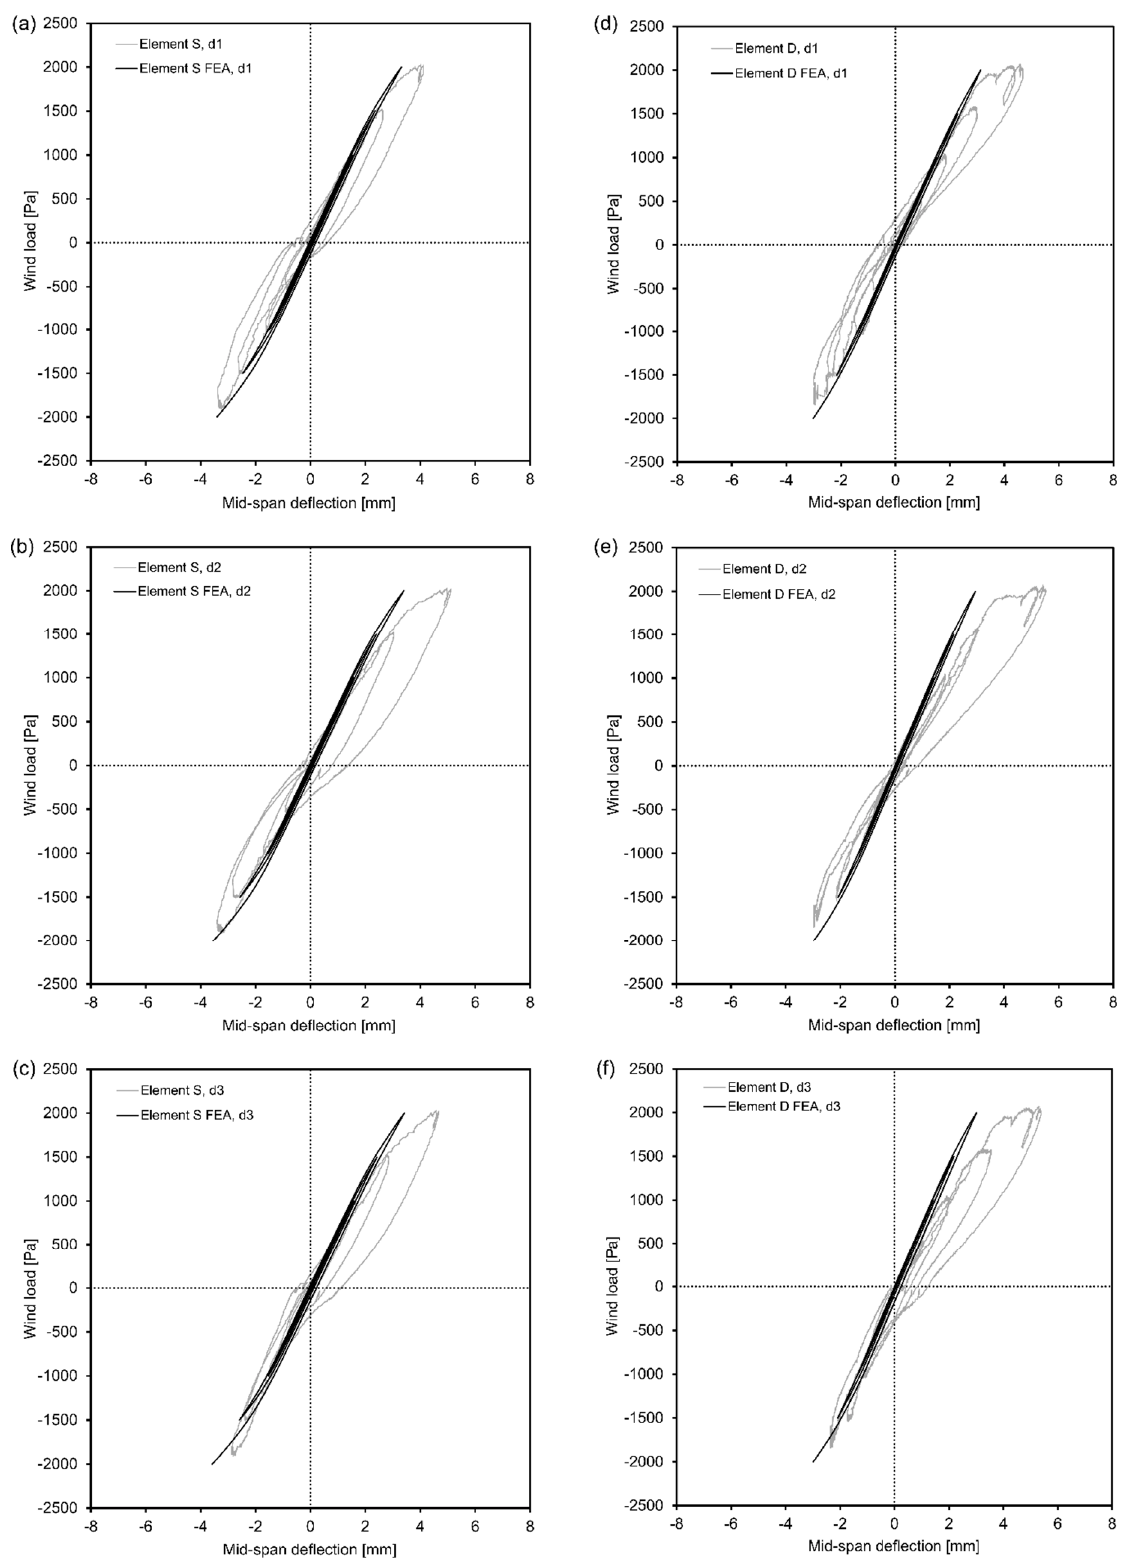
Figure 13. Comparison between experimental and finite element analysis (FEA) global behavior for the two sandwich element configurations with single (S) connectors ( a , b , c ) and double (D) connectors ( d , e , f ). Data pertaining to deflection locations d1 – d3 are indicated in the figures.